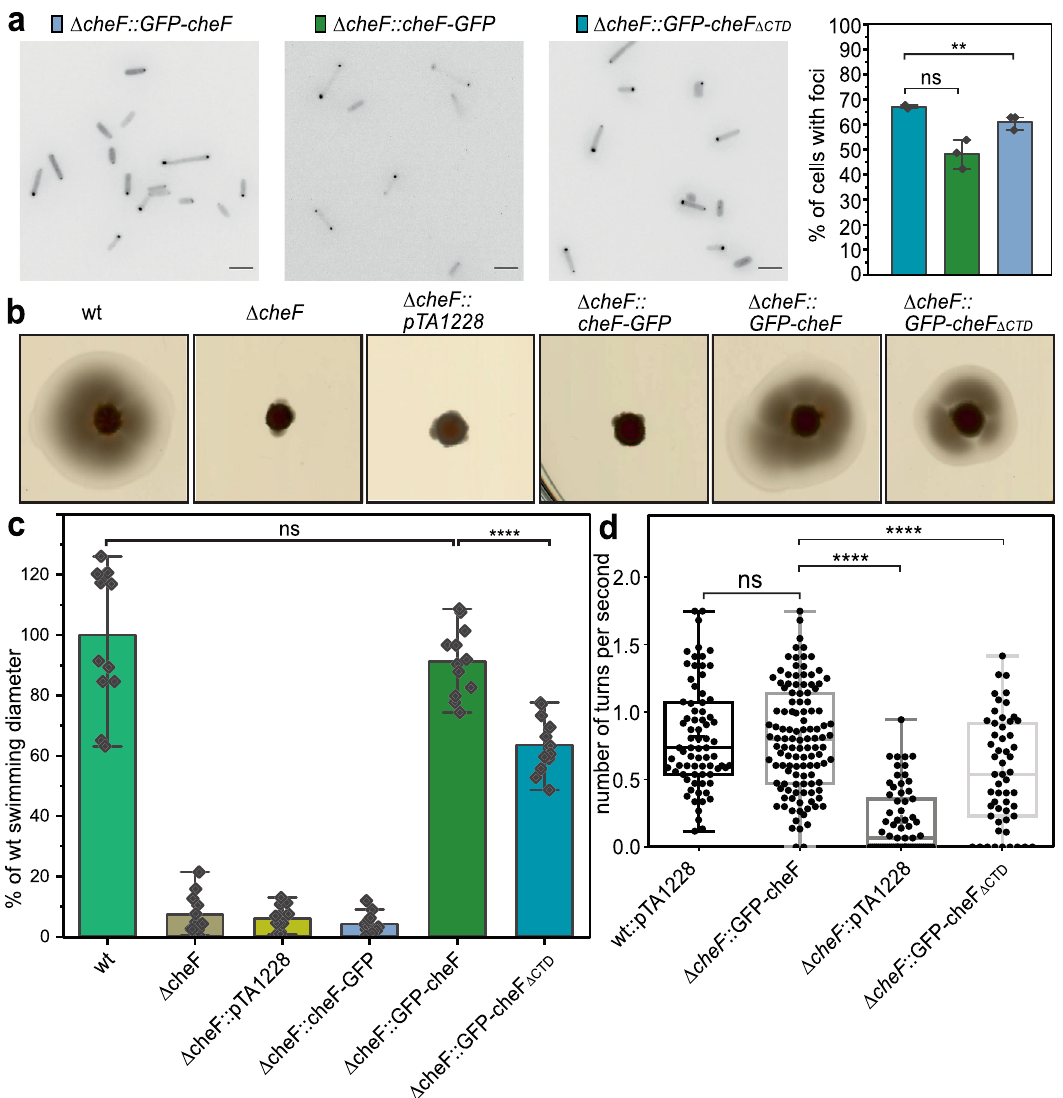
Fig. 3 Motility behavior of different CheF mutants in H. volcanii . a Representative fl uorescent images of intracellular distribution of GFP labeled CheF protein in the Δ cheF strain are shown. Scale bars, 4 μ m. (right panel) The percentages of cells with intracellular CheF foci in the 3 strains are shown. Data are represented as mean values ± standard deviation. The dots indicate the data from three biological replicates. Δ cheF :: cheF-GFP , n = 2569 cells, Δ cheF :: GFP-cheF , n = 1570 cells, Δ cheF :: GFP-cheF Δ CTD , n = 413 cells. cheF Δ CTD , encoding CheF protein with 83 aa C-terminal truncation. ns, not signi fi cant as determined by unpaired two-sided T-test ( p = 0.052). ** P < 0.01 ( p = 0.006). b Motility rings of different H. volcanii strains on semi-solid agar plates made of YPC medium. c Quanti fi cation of the diameter of the motility rings such as shown in a . The experiment was performed with at least three technical and two biological replicates (technical replicates are necessary because of the different humidity conditions in individual plates). WT, H. volcanii H26; Δ cheF , H. volcanii H26 deleted for cheF ; pTA1228, empty plasmid; cheF Δ CTD , encoding CheF protein with 83 aa C-terminal truncation. ns, not signi fi cant ( p = 0.251). **** P < 0.0001 as calculated with unpaired two-sided T-test. Data are represented as mean values± standard deviation. n = 13 experiments d . Swimming behavior of different H. volcanii strains expression a truncated version of CheF. Time lapse movies of swimming cells in liquid medium were analyzed and the average swimming behavior of individual cells is displayed in a box and whiskers plot. The whiskers show the minimum and maximum. The hinges of the box represent the 25 – 75 percentile and the middle line in the box is the median of all values. The frequency of reversals is measured as the time between two subsequent reversals (angle >90°). **** P < 0.0001 signi fi cantly different as established with unpaired two-sided T-test. ns, not signi fi cant as established by unpaired two-sided T-test, ( p = 0.371). The wt strain in the analysis is Δ pyrE2 (H26). pTA1228 empty plasmid. wt::pTA1228, n = 78 cells, Δ